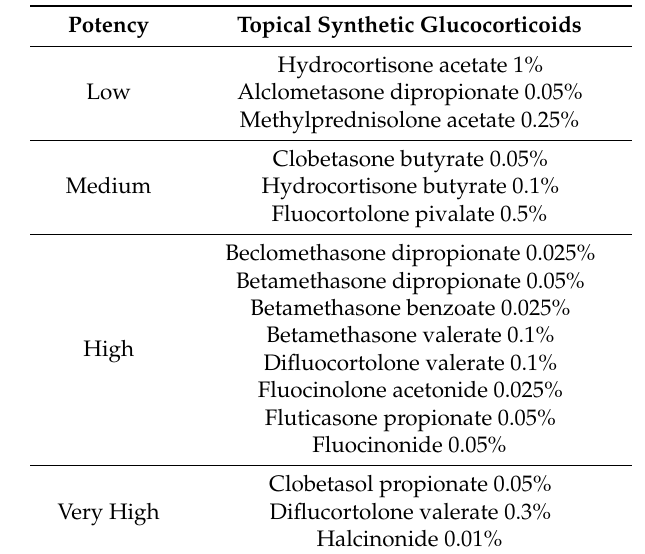
Table 3. Topical synthetic glucocorticoids (potency according to European Corticosteroids Classification)